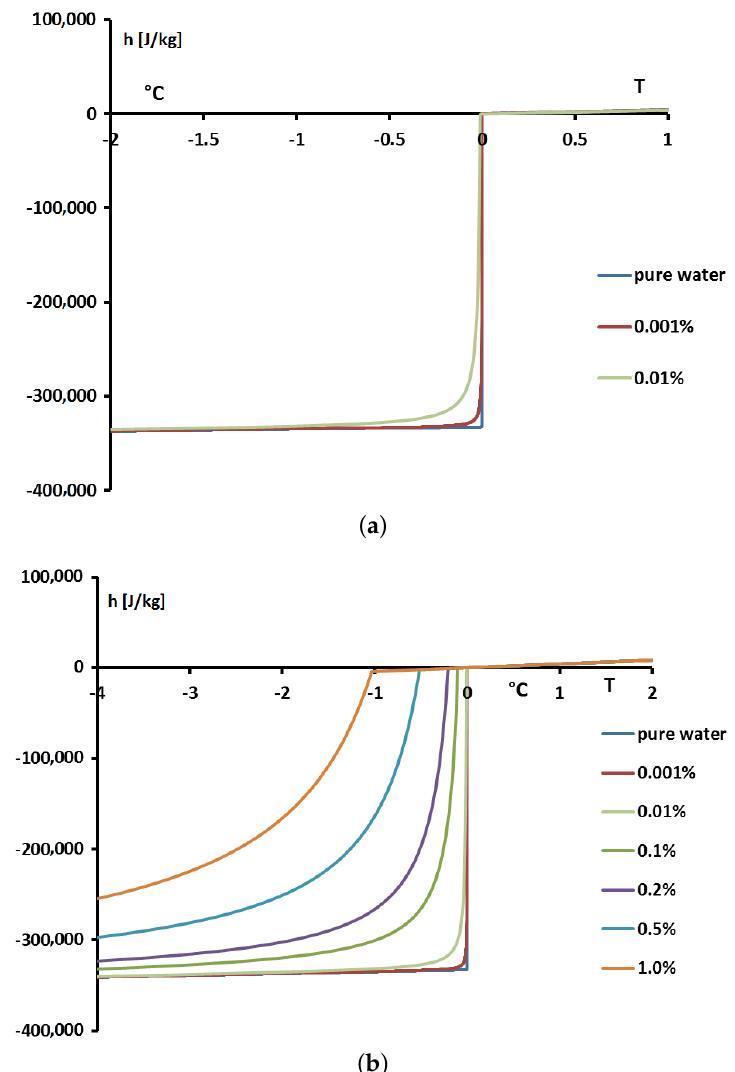
Figure 23. Examples of the specific enthalpy for aqueous saline solutions for very small concentrations (in percentage). ( a ) Very dilute cases; ( b ) Classical dilute